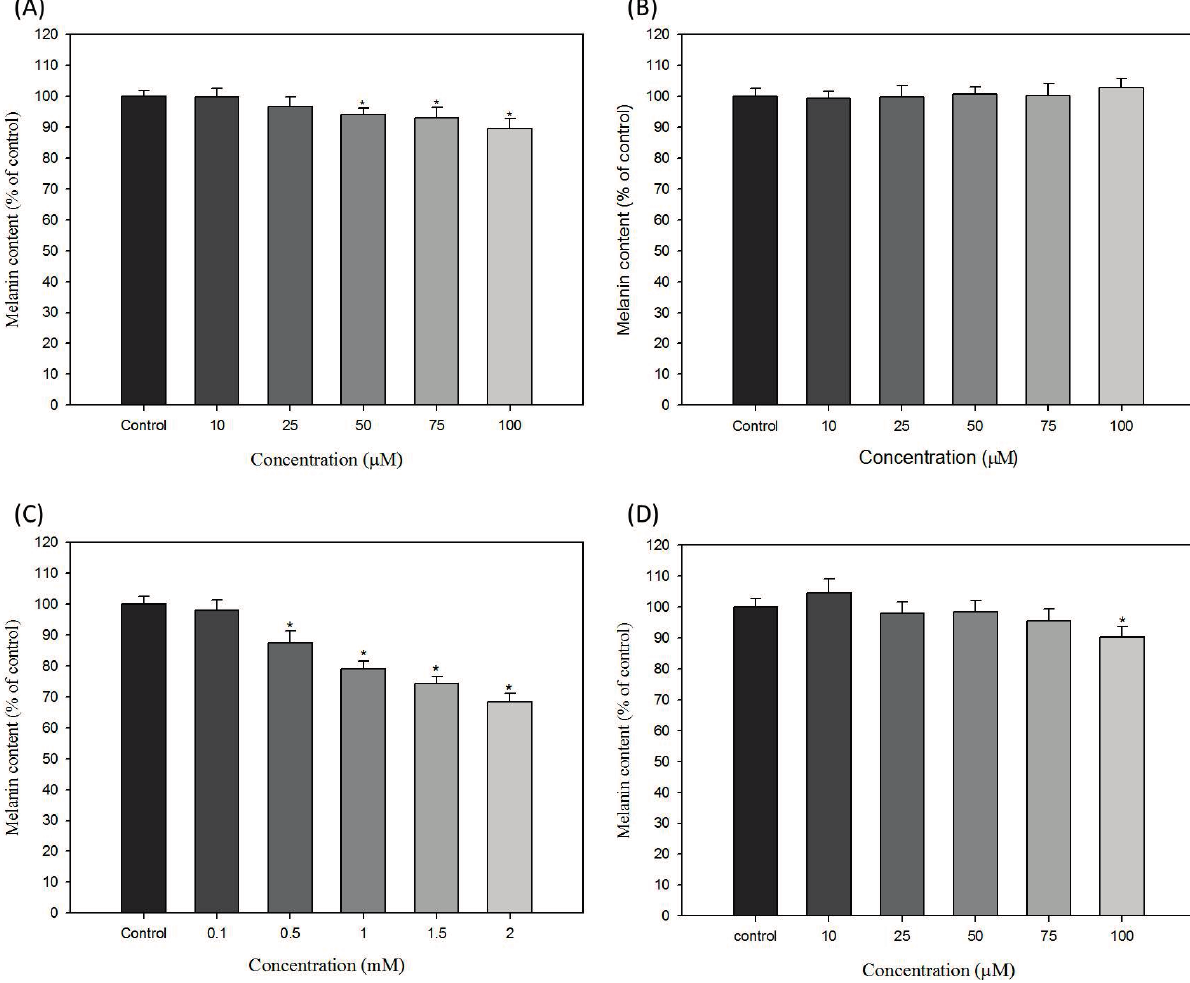
Figure 3. Effects of hair dyes on the melanin content of B16-F10 cells. ( A ) ammonium persulfate; ( B ) sodium persulfate; ( C ) resorcinol and ( D ) lawsone. Each value is expressed as the mean ± S.E. ( n = 6). * p < 0.05 compared with the